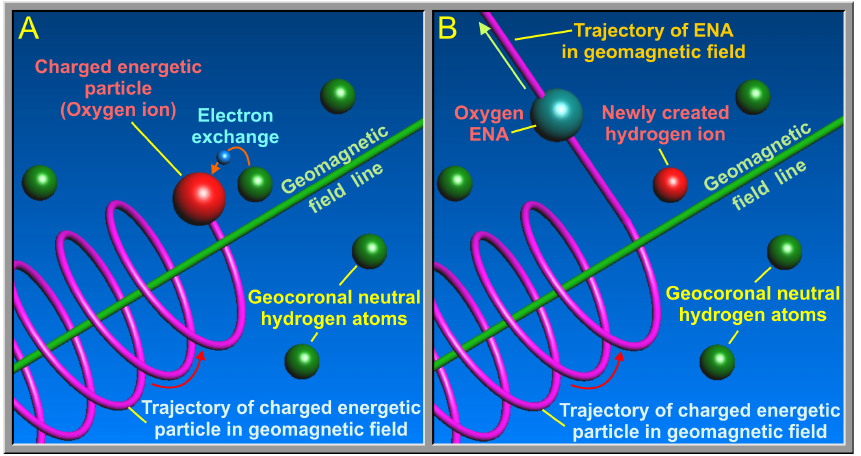
Fig. 1. An energetic plasma immersed in a neutral gas background emits energetic neutral atoms (ENAs), generated due to the charge exchange process. The example provided is for an oxygen ion, but the charge exchange interaction is valid for any singly charged ion.